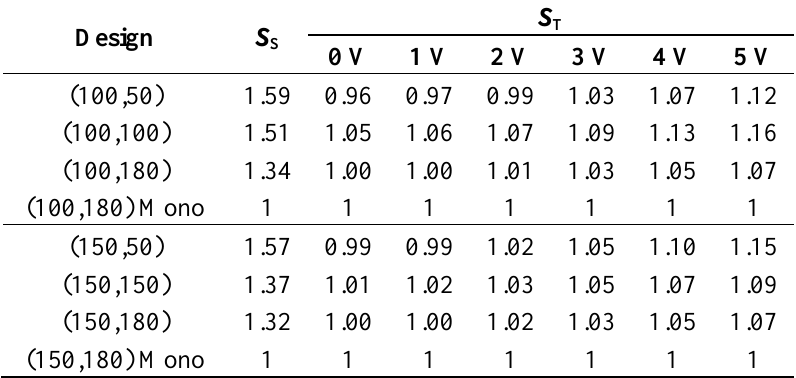
) for different ( l , l 0